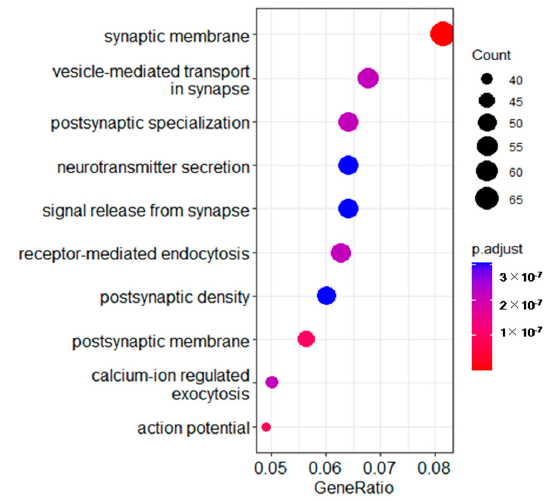
Figure 4. The top 10 most significantly enriched Gene Ontology (GO) terms from the expressed genes. The size of the dots represents the number of genes for different terms. The p.adjust differentially expressed genes. The size of the dots represents the number of genes for values are indicated by changing colors, moving from red to different terms. The p.adjust values are indicated by changing colors, moving from red to blue.